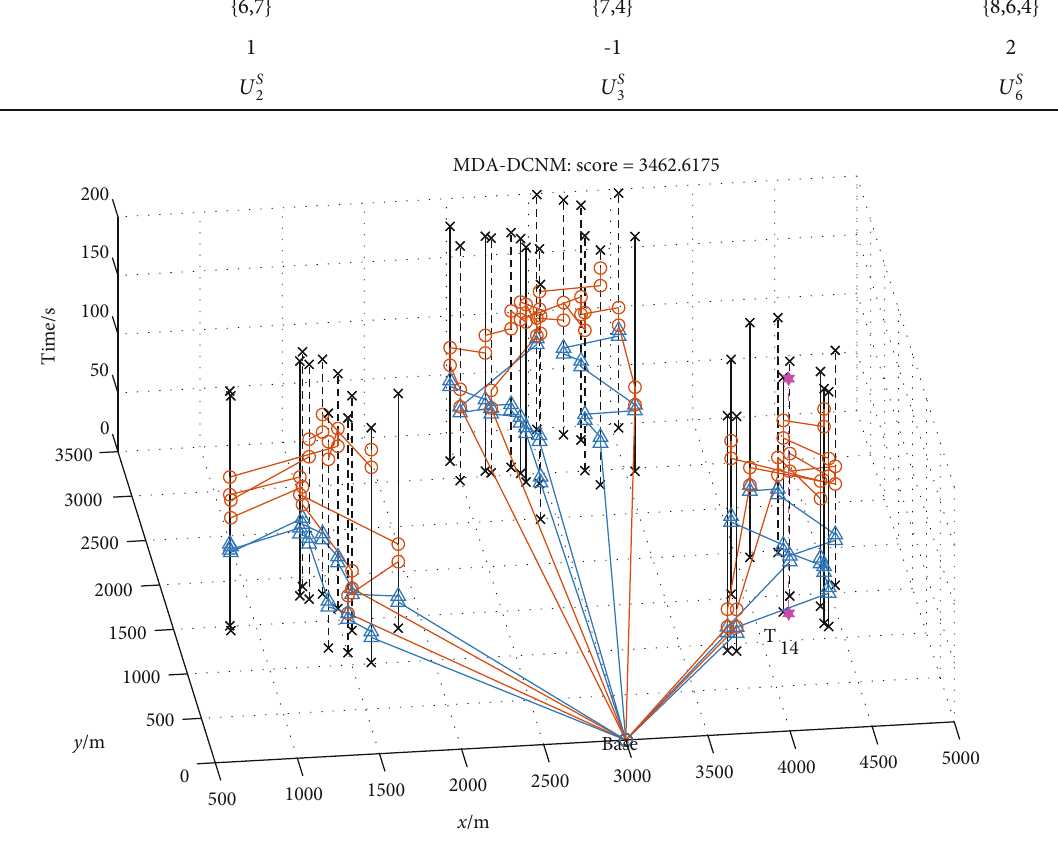
Figure 7: Task assignment results of MDA-DCNM with unbalanced capacities of R